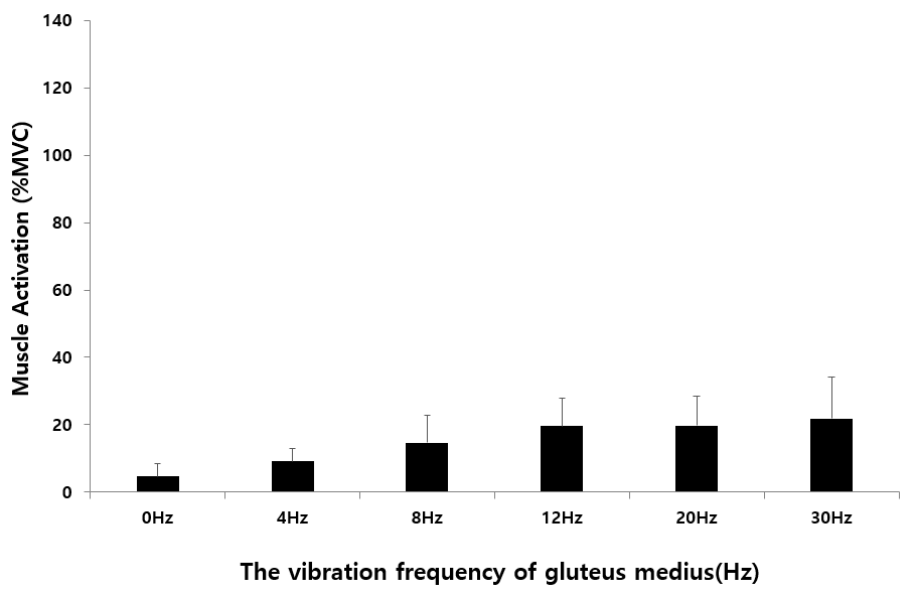
Figure 3. Results of gluteus medius muscle activation according to vibration frequency conditions